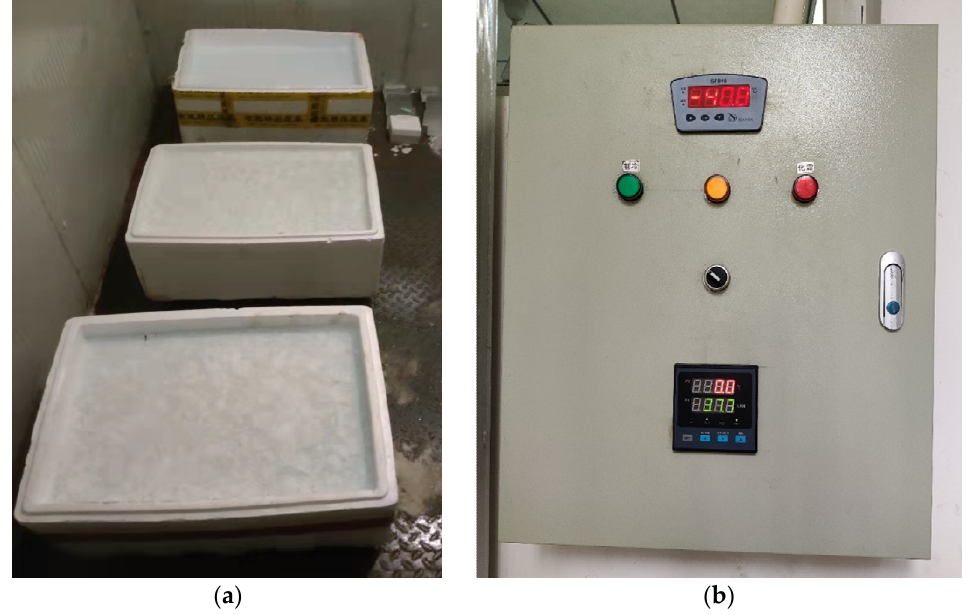
Figure 1. Ice preparation and cryogenic laboratory temperature control panel. ( a ) Plastic foam condensation tanks filled with distilled water in a cryogenic laboratory. ( b )Temperature control panel.